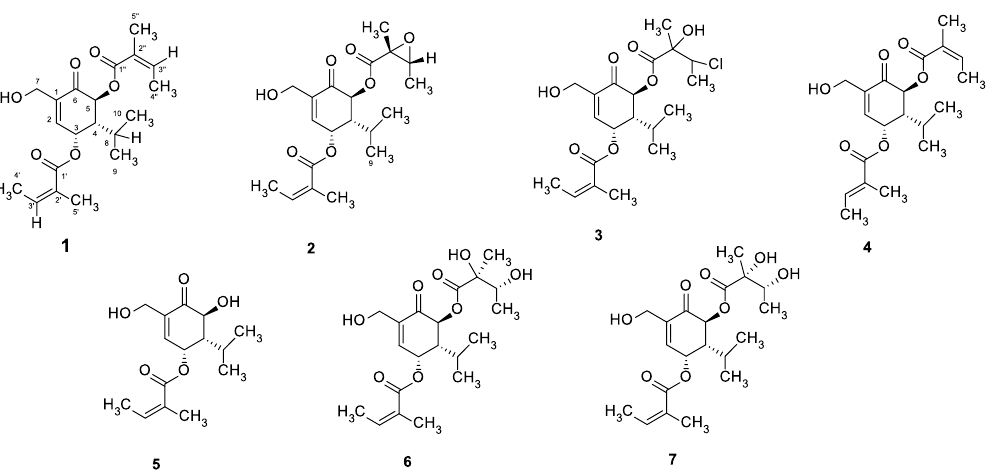
Figure 1. Chemical structures of compounds 1–7 isolated from Sphaeranthus africanus [21,22].